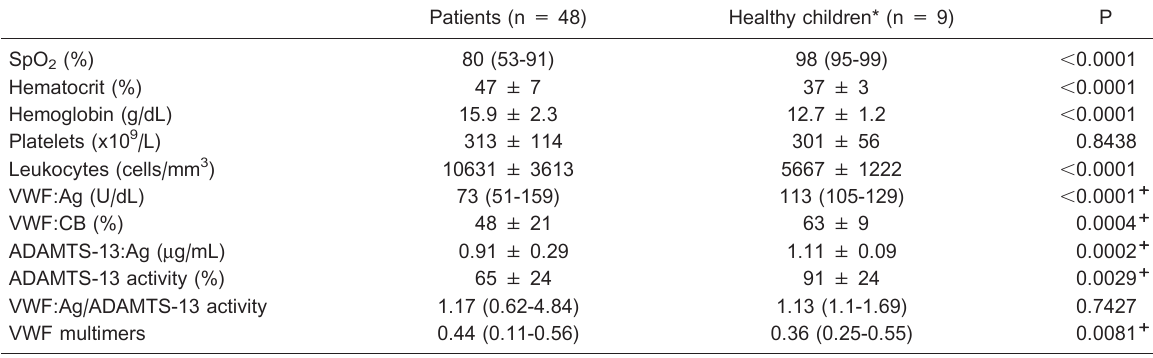
Table 1. Baseline laboratory